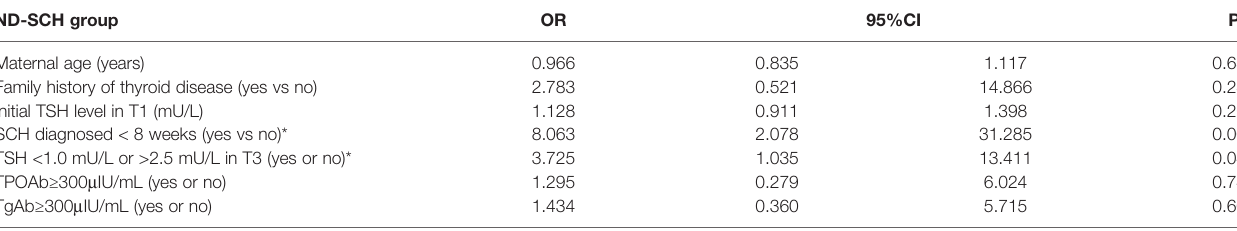
TABLE 2 | Logistic regression model for the risk factors of developing PPT in women with ND-SCH (n = 50). ND-SCH group OR 95%CI P Maternal age